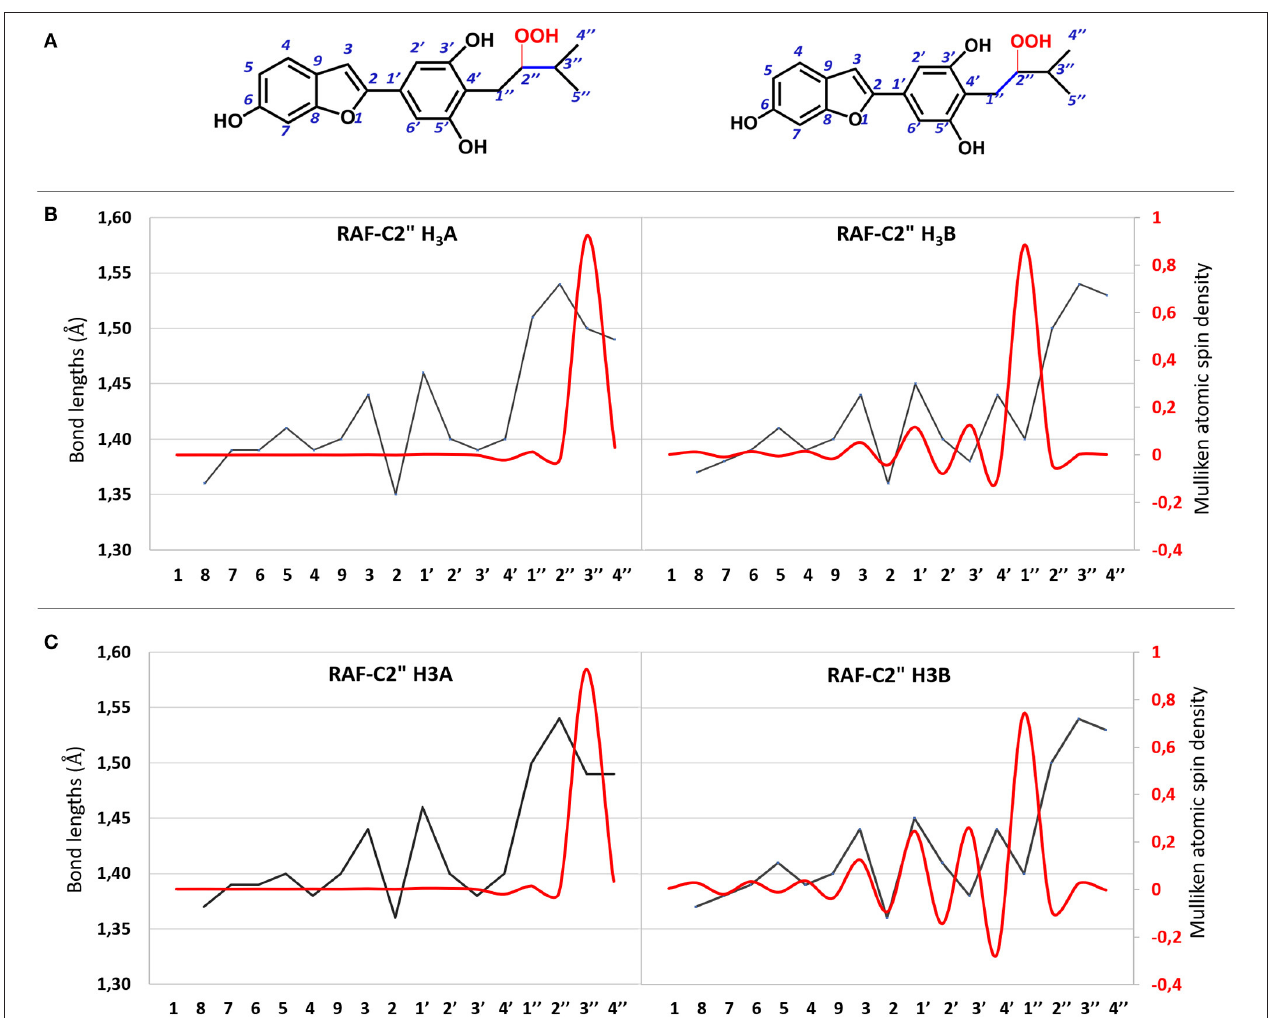
FIGURE 6 | (A) 2D representation of OOH addition to the C2 ′′ atom of moracin C and iso-moracin C. (B) CC bond lengths (black line) and atomic spin density (red line) for the OOH addition to the C2 ′′ atom in water enviroment. (C) CC bond lengths (black line) and atomic spin density (red line) for the OOH addition in PE environment.